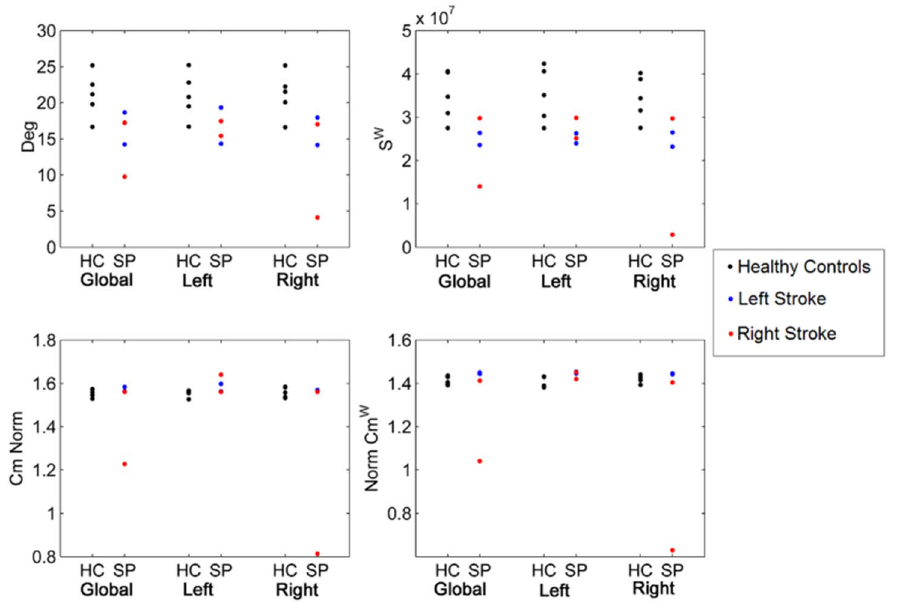
Fig. 6. Global and hemispheric network metrics of Deg, Cm, S w and Cm w for healthy controls (HC) against stroke patients (SP).